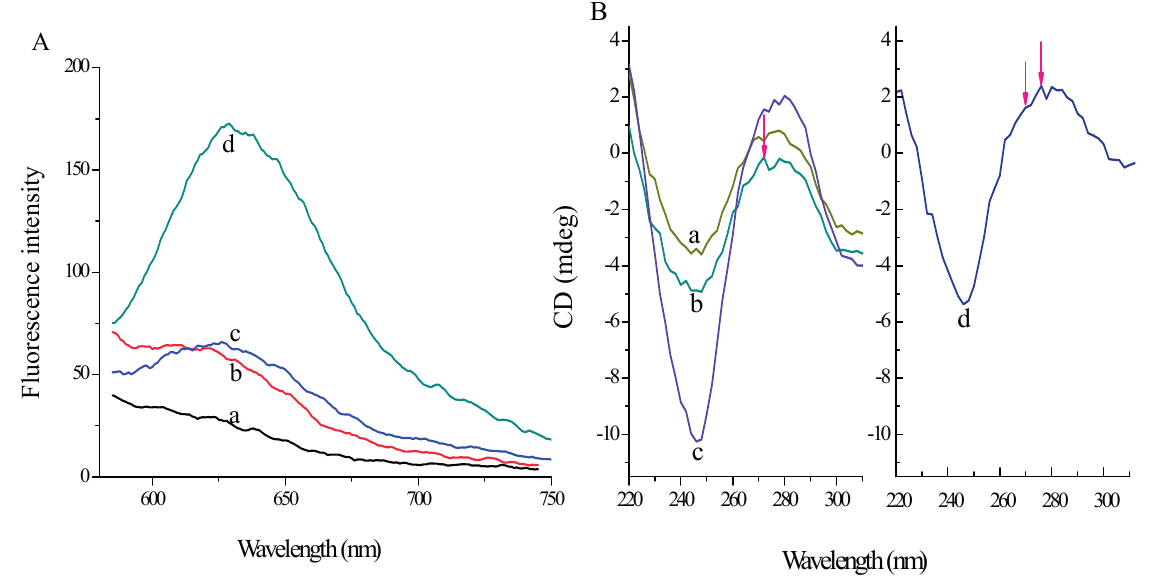
Figure 3. ( A ) Fluorescence spectra of (a) 10 − 5 mol·L − 1 quinaldine red; (b) 10 mg·L − 1 GO + 10 − 5 mol·L − 1 quinaldine red; (c) 10 mg·L − 1 GO + 10 − 7 mol·L − 1 probe 2 + 10 − 5 mol·L − 1 quinaldine red; (d) 10 mg·L − 1 GO + 10 − 7 mol·L − 1 probe 2 + 3 × 10 − 7 mol·L − 1 T-DNA + 10 − 5 mol·L − 1 quinaldine red; ( B ) CD spectra of (a) probe 2; (b) GO + probe 2; (c) GO + probe 2 + T-DNA; (d) CD spectrum of subtracting curve b from